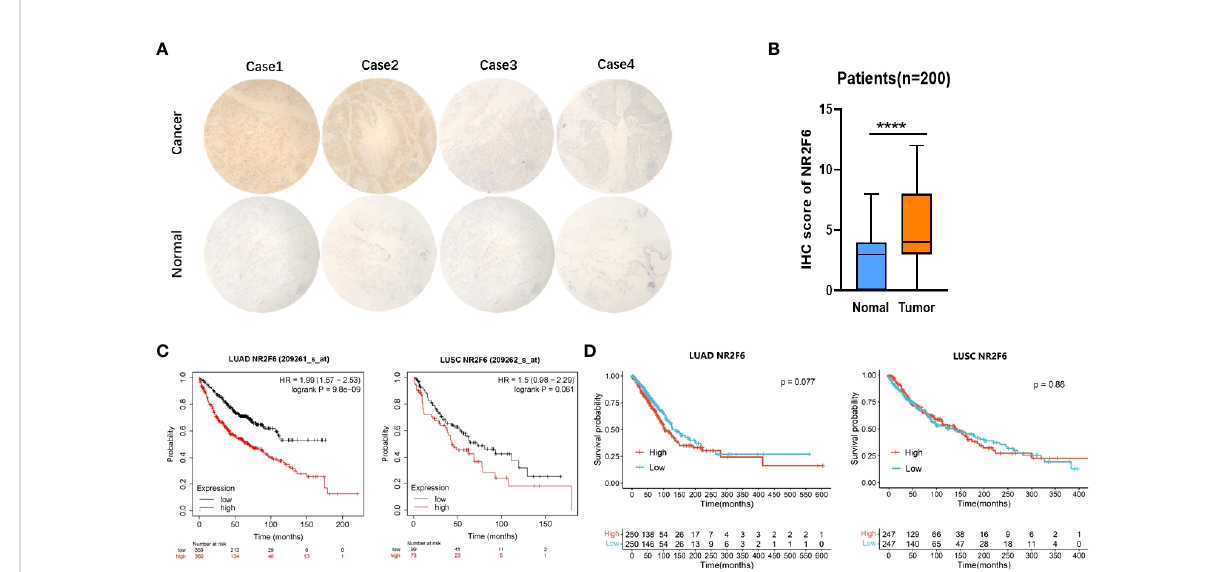
FIGURE 2 The expression of NR2F6 in lung cancer tissues was signi fi cantly higher than that in para-carcinoma tissues and was associated with poor prognosis. (A) Immunohistochemical results. The above four images show lung cancer tissues, representing strong positive, positive, weak positive, and negative staining, respectively. The four images below show the corresponding staining results of para-carcinoma tissues. (B) The immunohistochemical results showed that NR2F6 protein expression in lung cancer tissues was signi fi cantly higher than that in para-carcinoma tissues, and the difference was statistically signi fi cant. (C) The Kaplan – Meier Plotter was used to analysis the NR2F6 expression and prognosis of LUAD and LUCS. (D) TCGA datebase was used to analysis the NR2F6 expression and prognosis of LUAD and **** P <